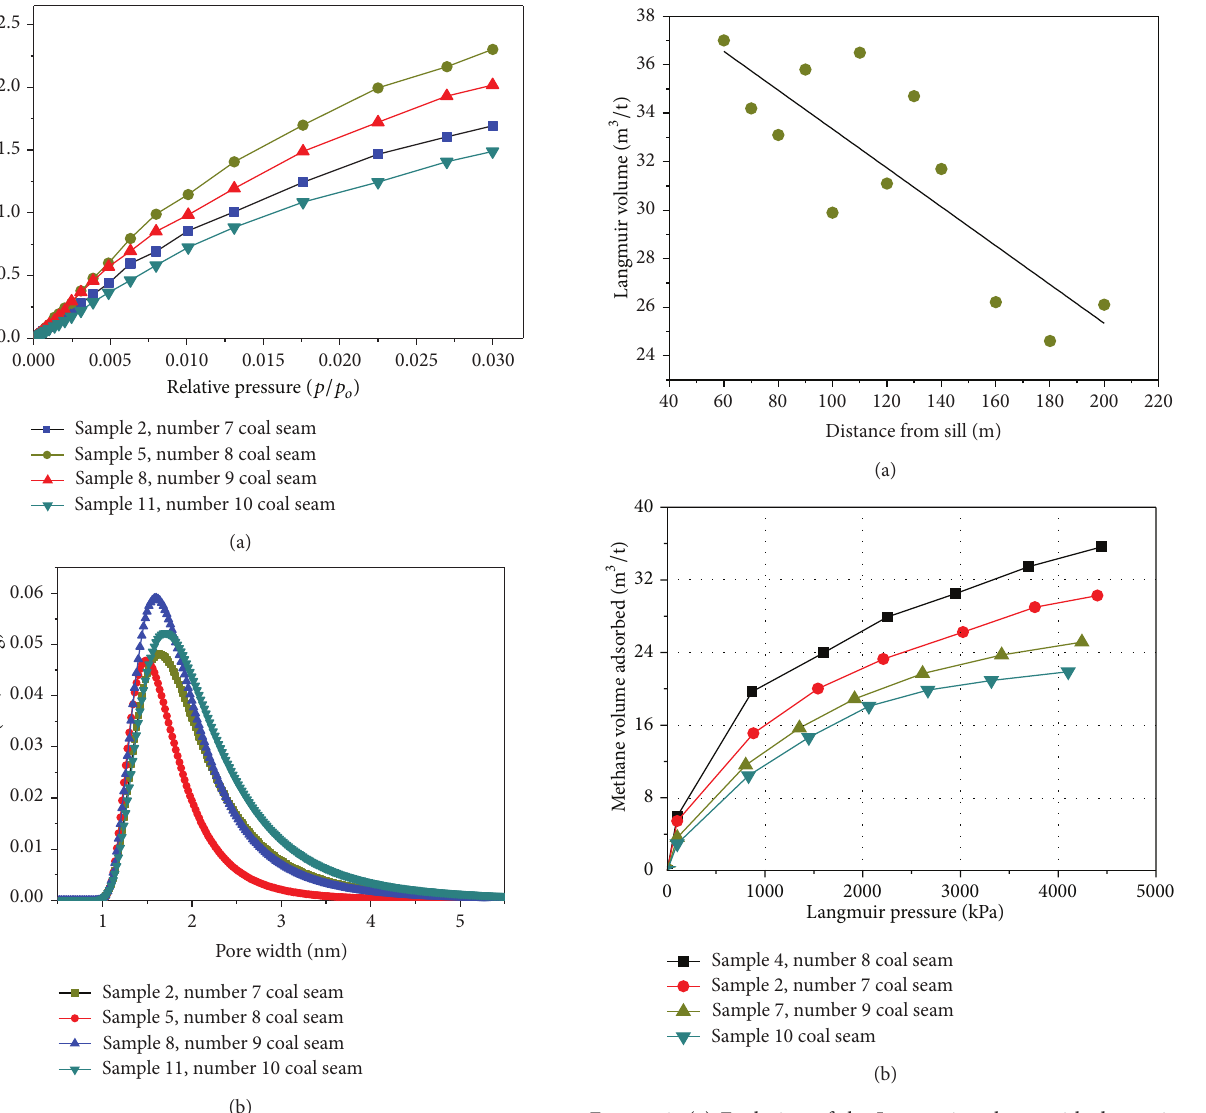
Figure 9: (a) Evolution of the Langmuir volume with decreasing distance from sill and (b) comparison of gas (methane) adsorption behavior of four samples: sample 2, sample 4, and sample 7 in heat- affected zone and sample 10 in unaltered